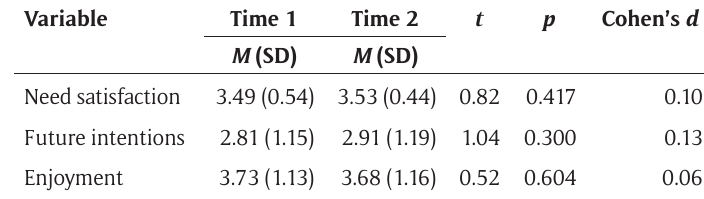
Table 3: Comparison of time-1 and time-2 values of the mean scores for each measurement instrument for the science